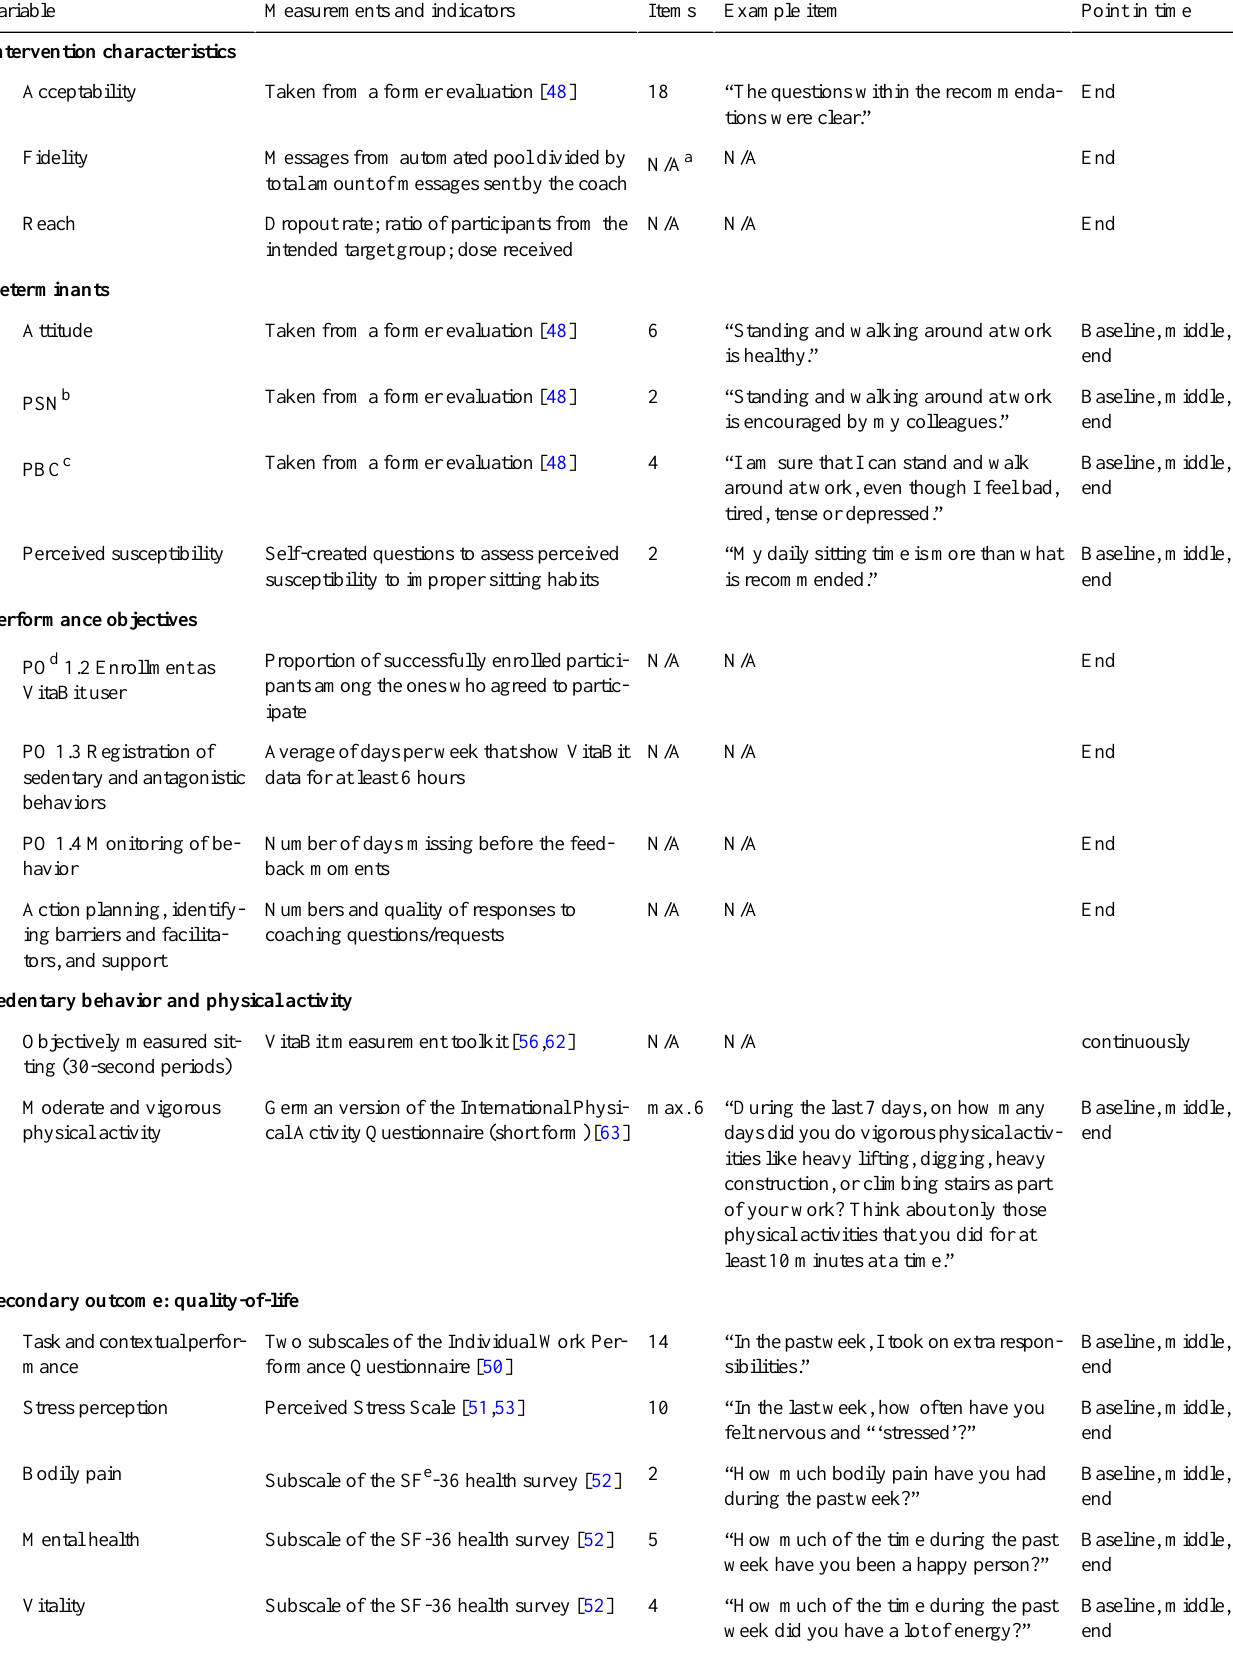
Point in timeExample itemItemsMeasurements and indicatorsVariable